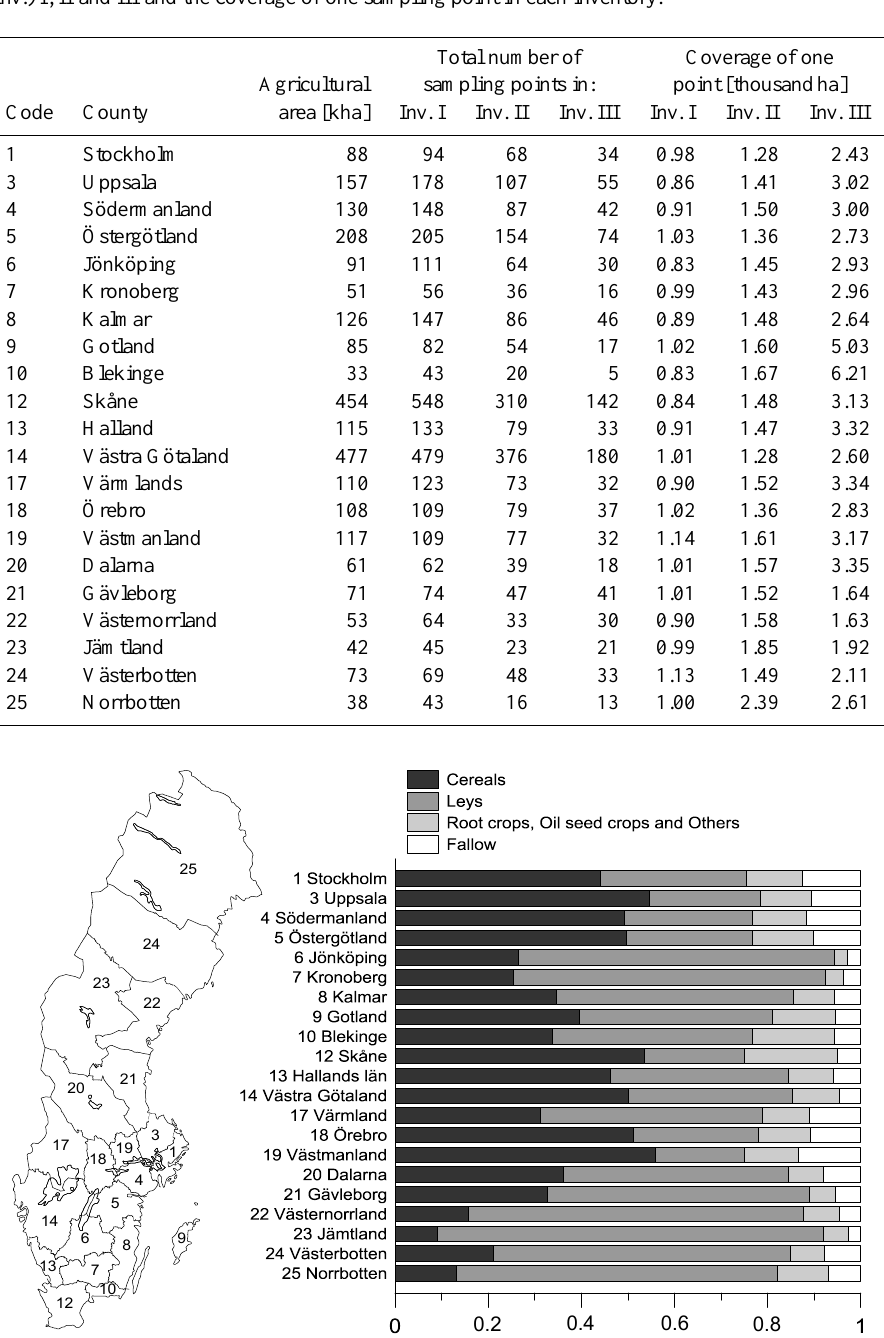
Figure 2. (Left) Map of Sweden showing the current division into counties, numbered according to the codes listed in Table 1. (Right) Relative proportions of different crops grown on the agricultural area in each county, averaged for the period